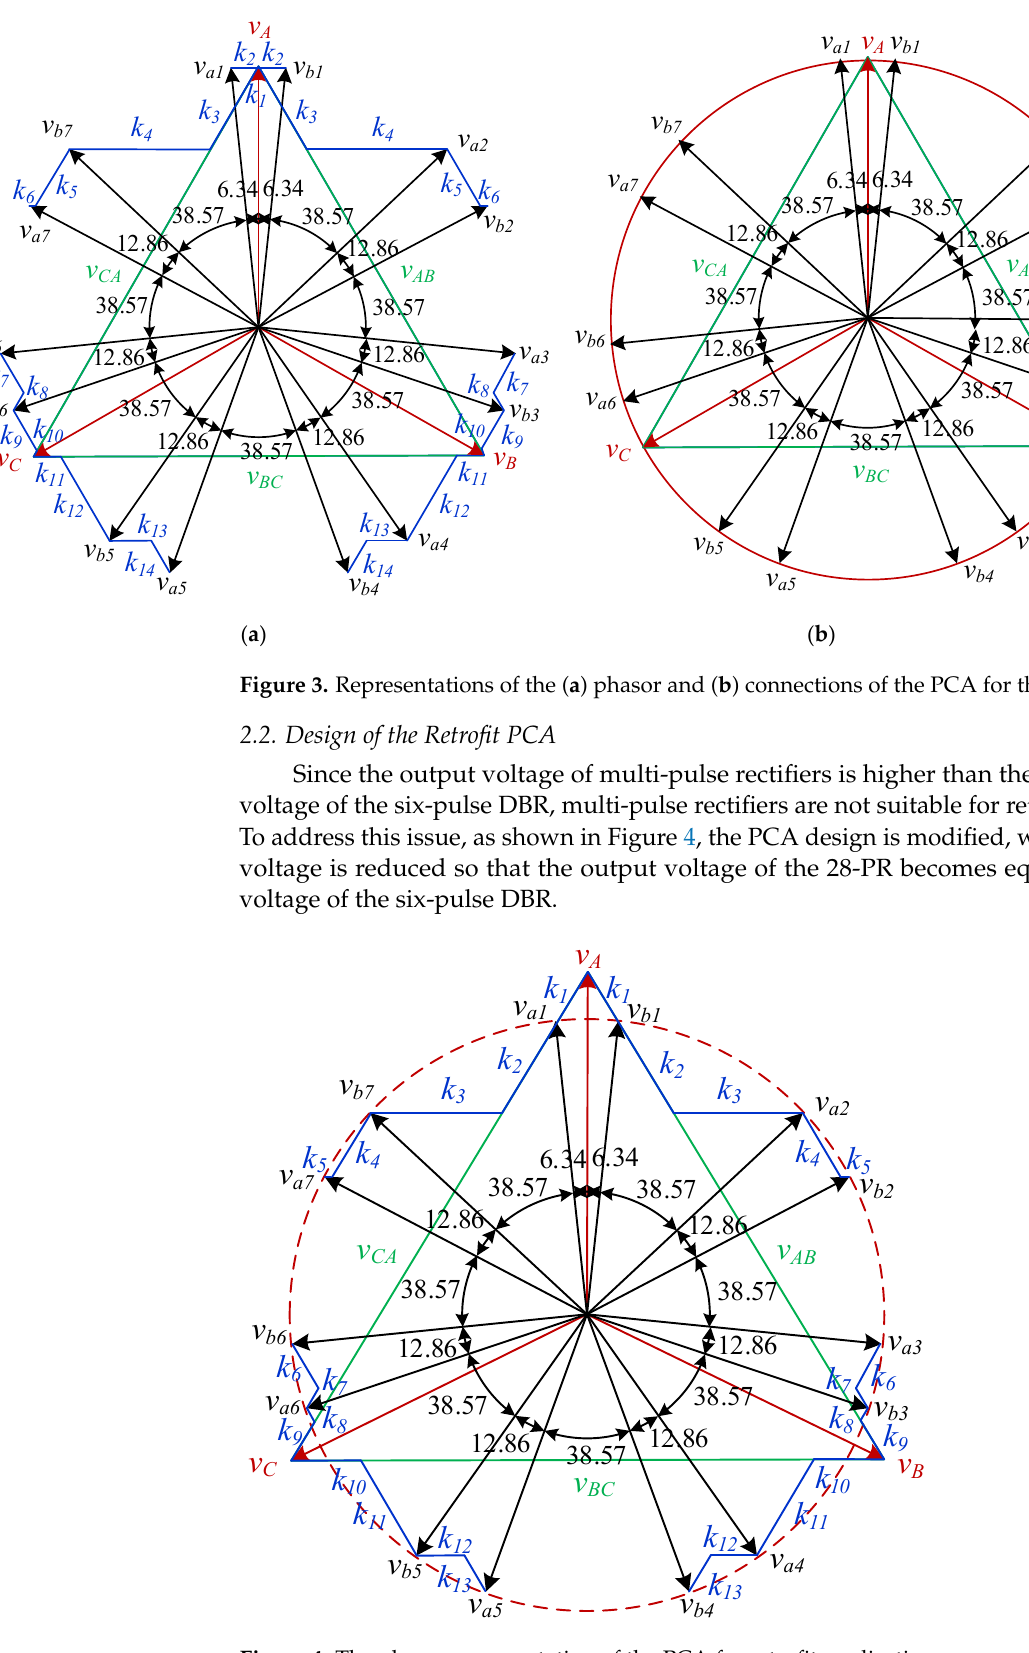
Figure 4. The phasor representation of the PCA for retrofit applications.